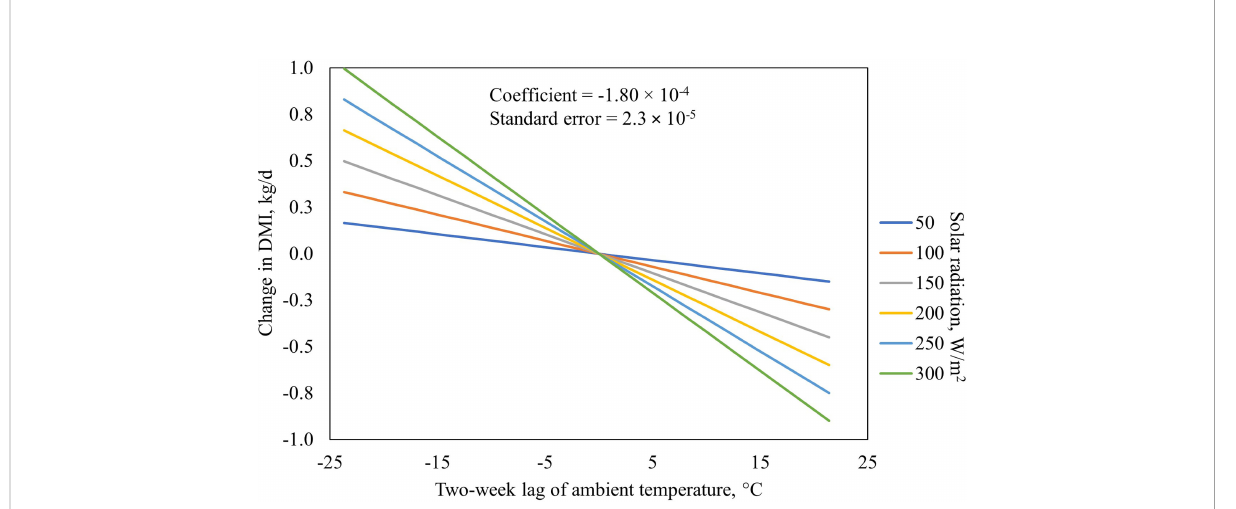
FIGURE 3 The fi nal model interaction between two-week lag of ambient temperature and monthly lag of solar radiation and their in fl uence on dry matter intake (DMI). F-value = 61.92. P -value <